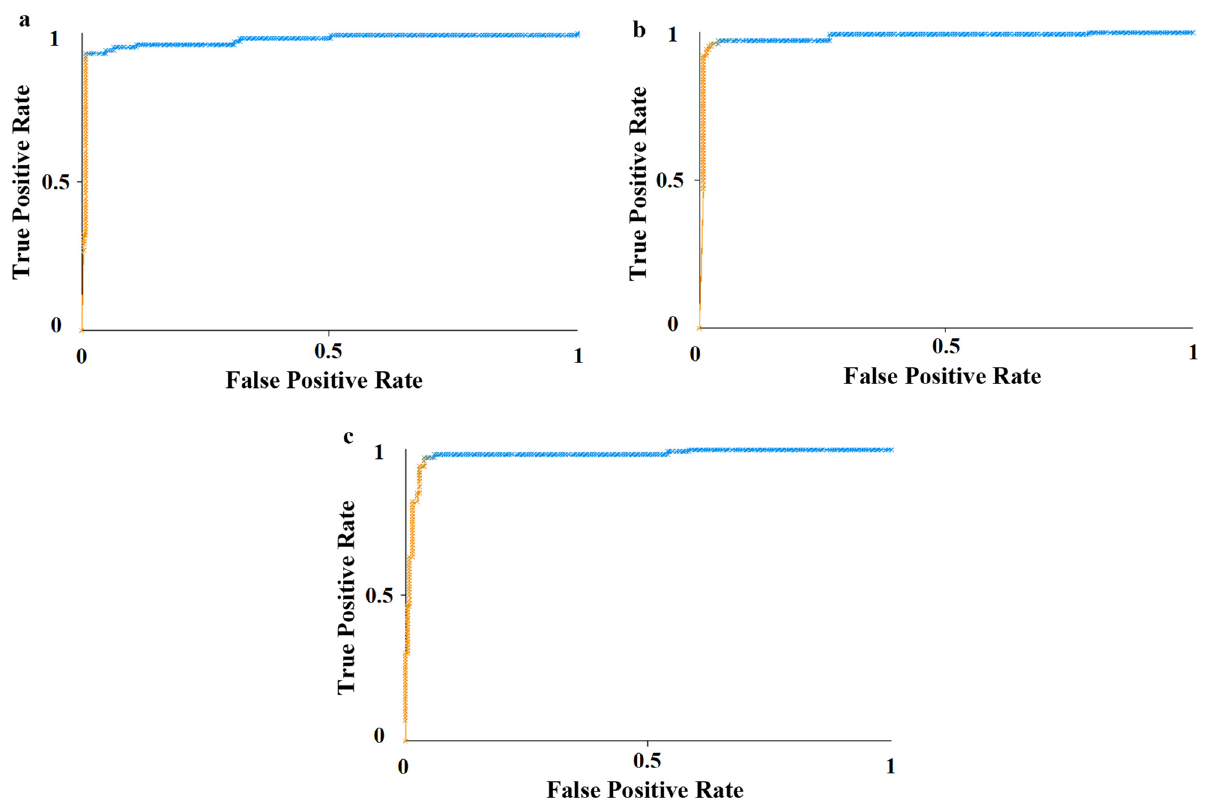
Figure 4. The ROC (Receiver Operating Characteristic) curves for the cultivar discrimination of plum kernels for a model built using the LMT classifier based on textures selected from all color channels, ( a ) ‘Emper’, ( b ) ‘Kalipso’, ( c ) ‘Polinka’.